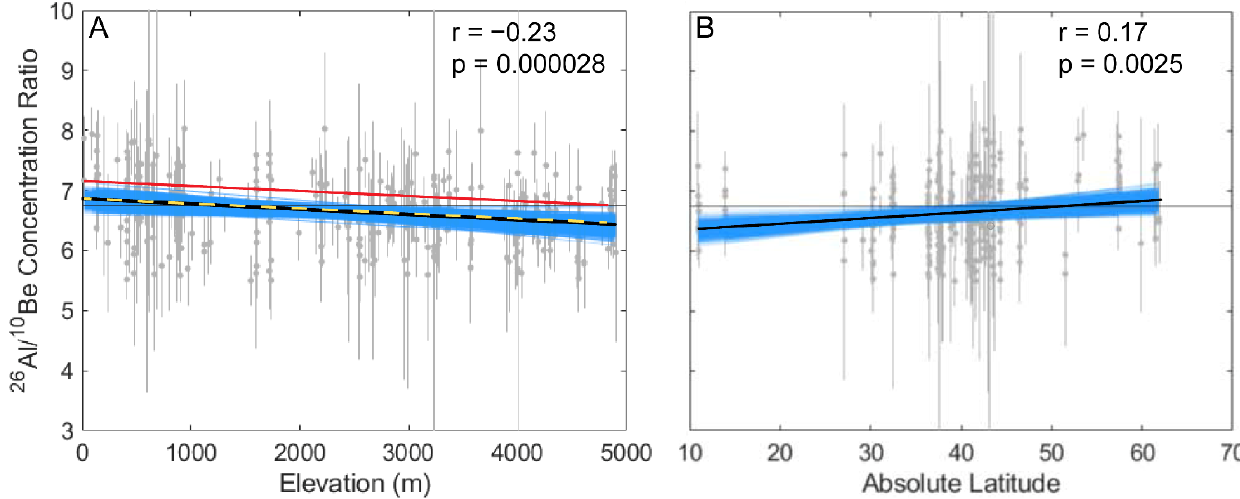
Figure 4. Linear regressions correlating measured 26 Al/ 10 Be concentration ratios to elevation ( A ) and latitude ( B ). Gray data points are the same as Figure 3. Central, solid black line in each figure is the most likely regression. Thin, blue lines are individual Monte Carlo regressions. Gray horizontal line shows a ratio of 6.75. Dashed yellow line in (A) shows the expected change in ratio with elevation from LSDn scaling at 5° latitude. Solid red line in 4A is the same but at 60° latitude.